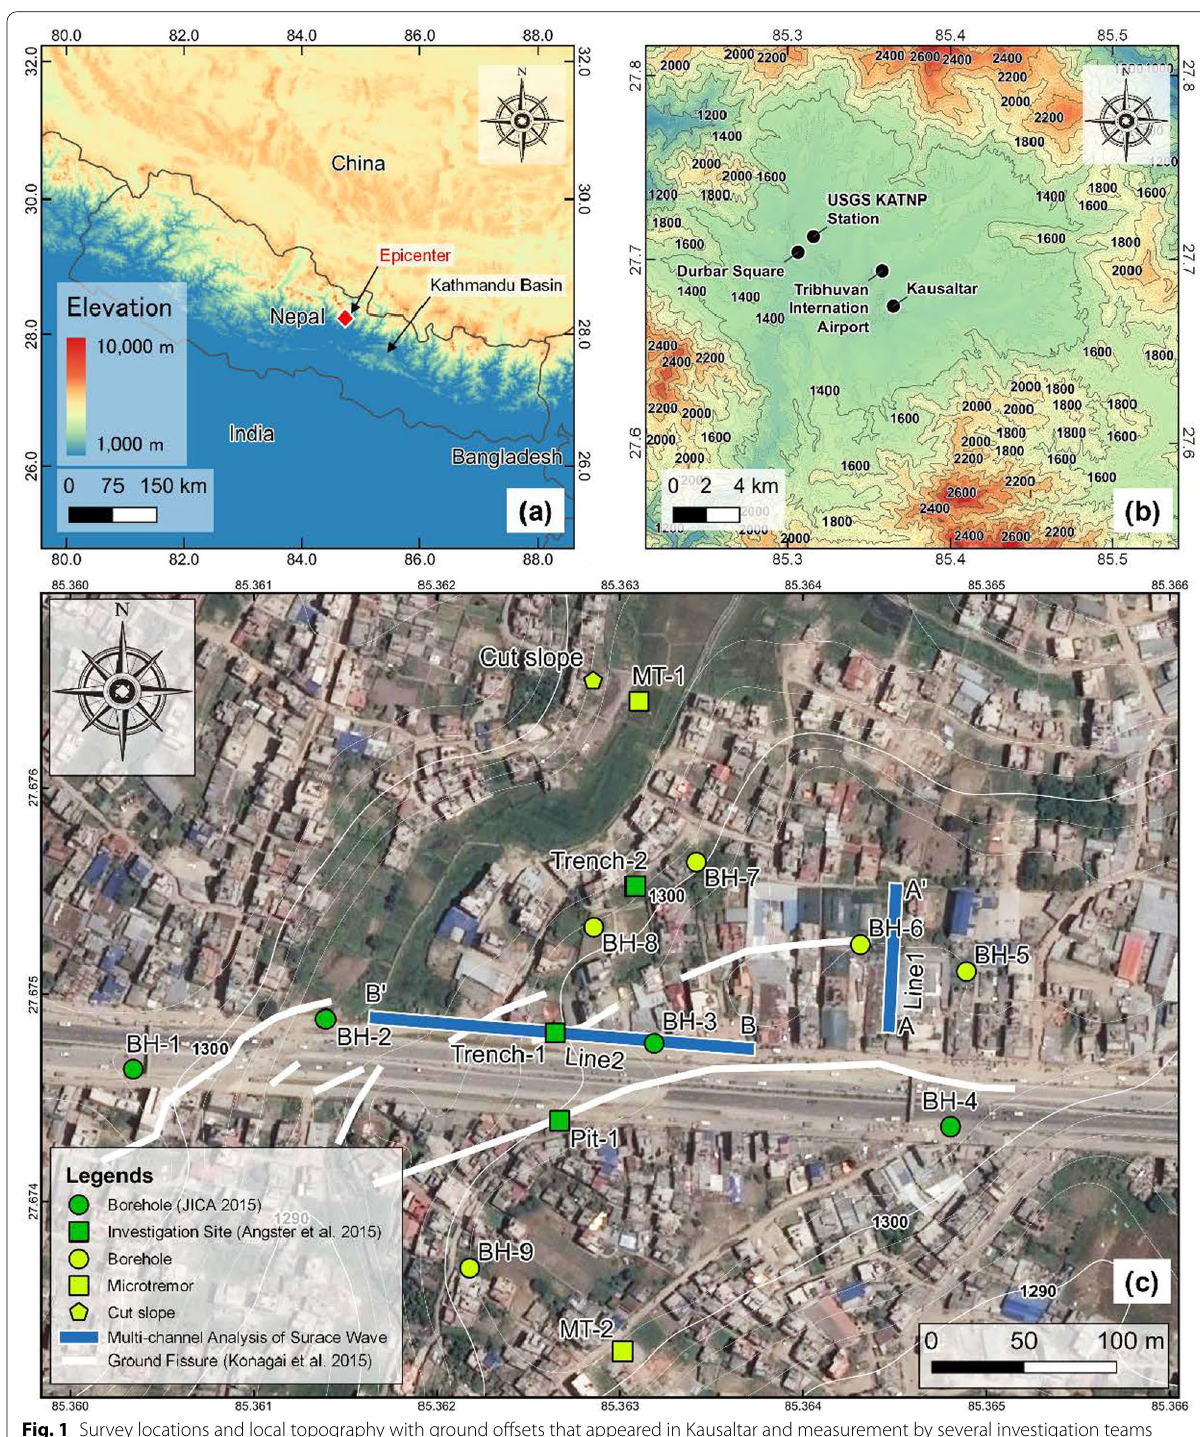
Fig. 1 Survey locations and local topography with ground offsets that appeared in Kausaltar and measurement by several investigation teams (Konagai et al. 2015; JICA 2015; Angster et al. 2015) a Entire Map with digital terrain model from JAXA b Regional Map with digital terrain model from JAXA c Local Map with overlaid on an aerial image from Google